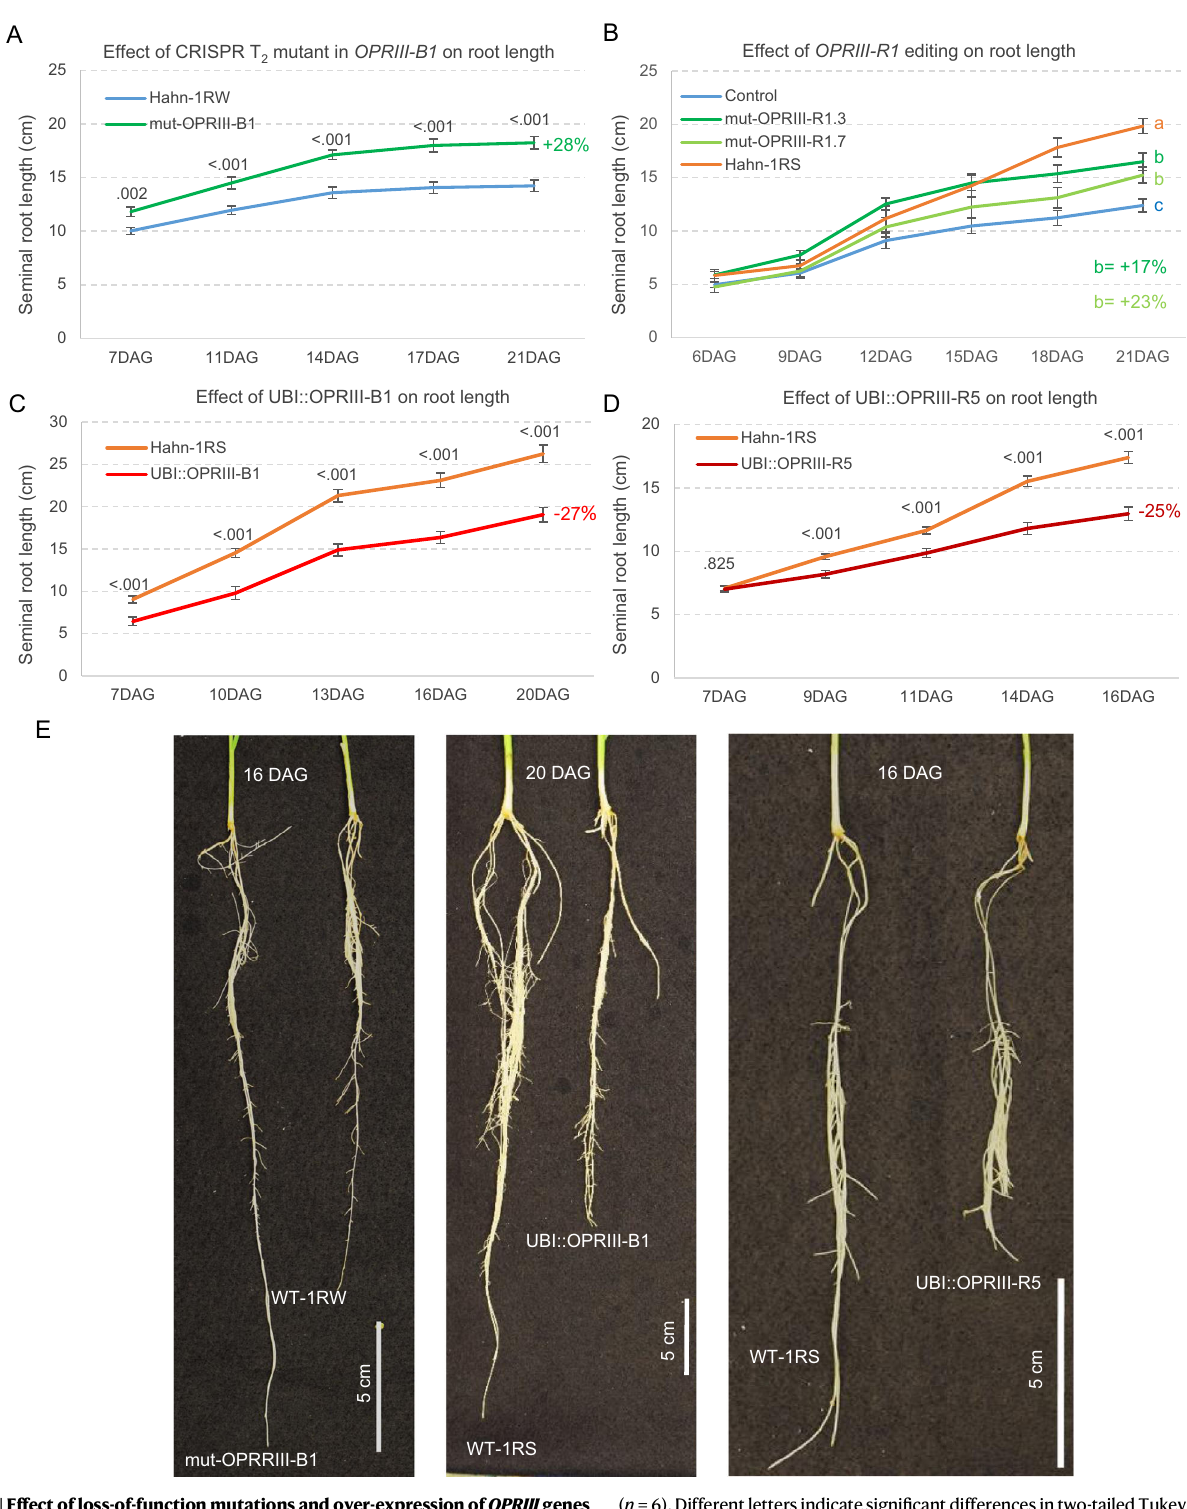
each time point. A – D Dataare presented as means values±SEM. E Images ofroots lengths in the same genotype comparisons as in ( A ), ( C ) and ( D ). Source data are provided as a Source Data fi